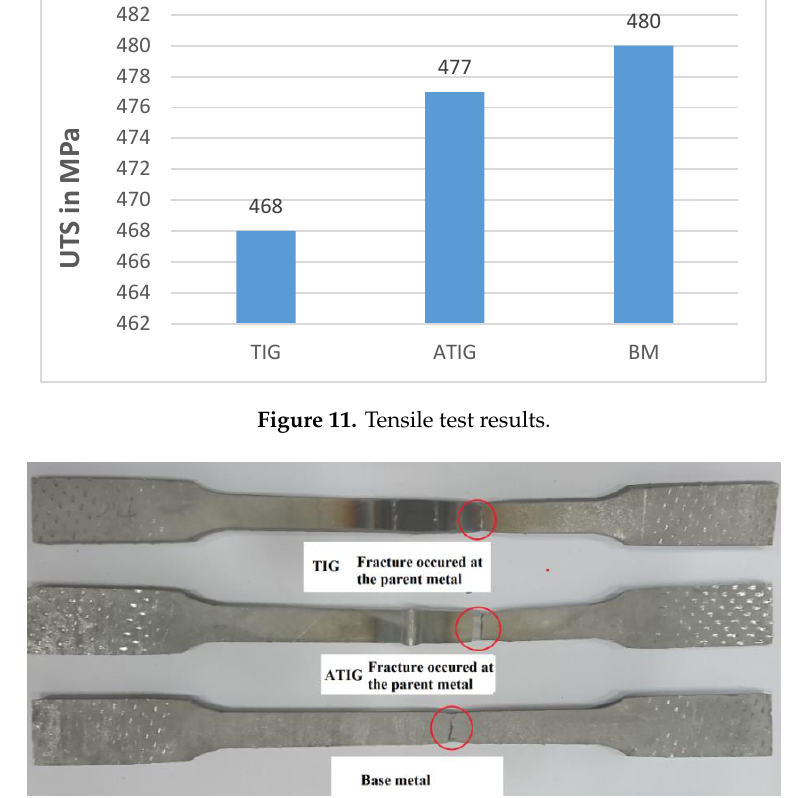
Figure 12. Fracture zones in base metal, TIG weld and in ATIG weld. Table 7. Mesurments of tensile strenght and standards deviation of TIG and ATIG (optimal